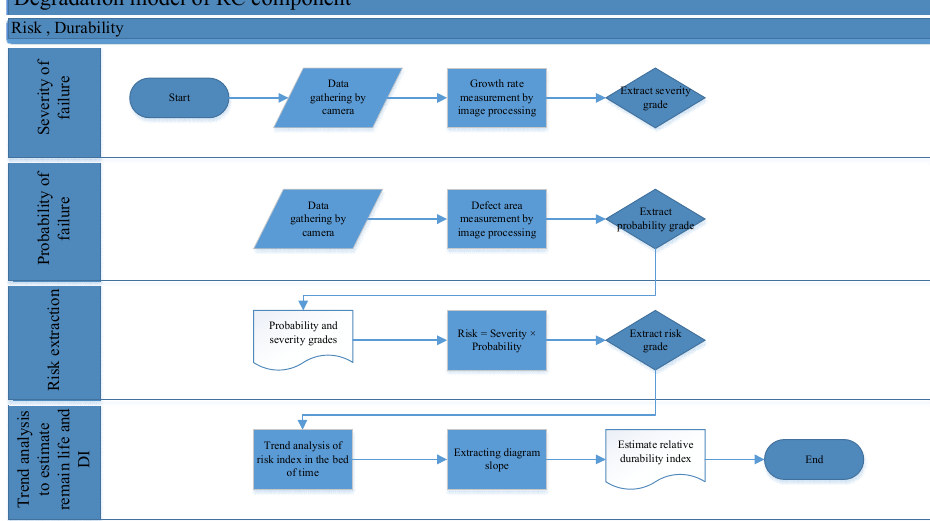
Figure 4. Case study subject–RC element. When fixing the camera to the ground, the location of its stand was marked for the second data gathering session. Additionally, the drainage hole was a potential place for defect expansion and the extraction of data for the durability index due to these changes was carried out. After a comparison of the images, significant changes were found to exist between the first data gathering session and the second, which was encouraging for the research aim.